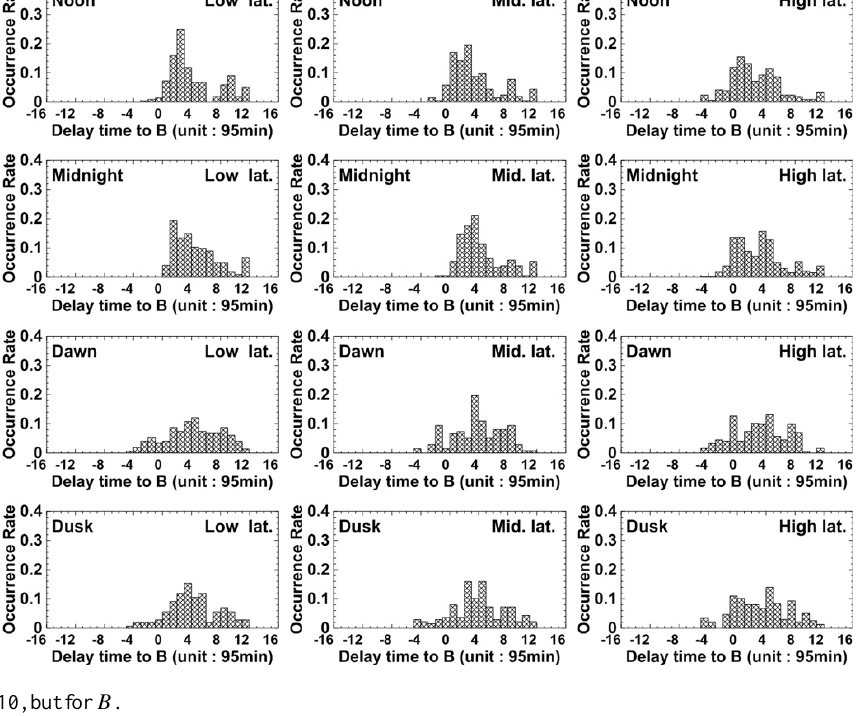
Fig. 13. Same as Fig. 10, but for B .